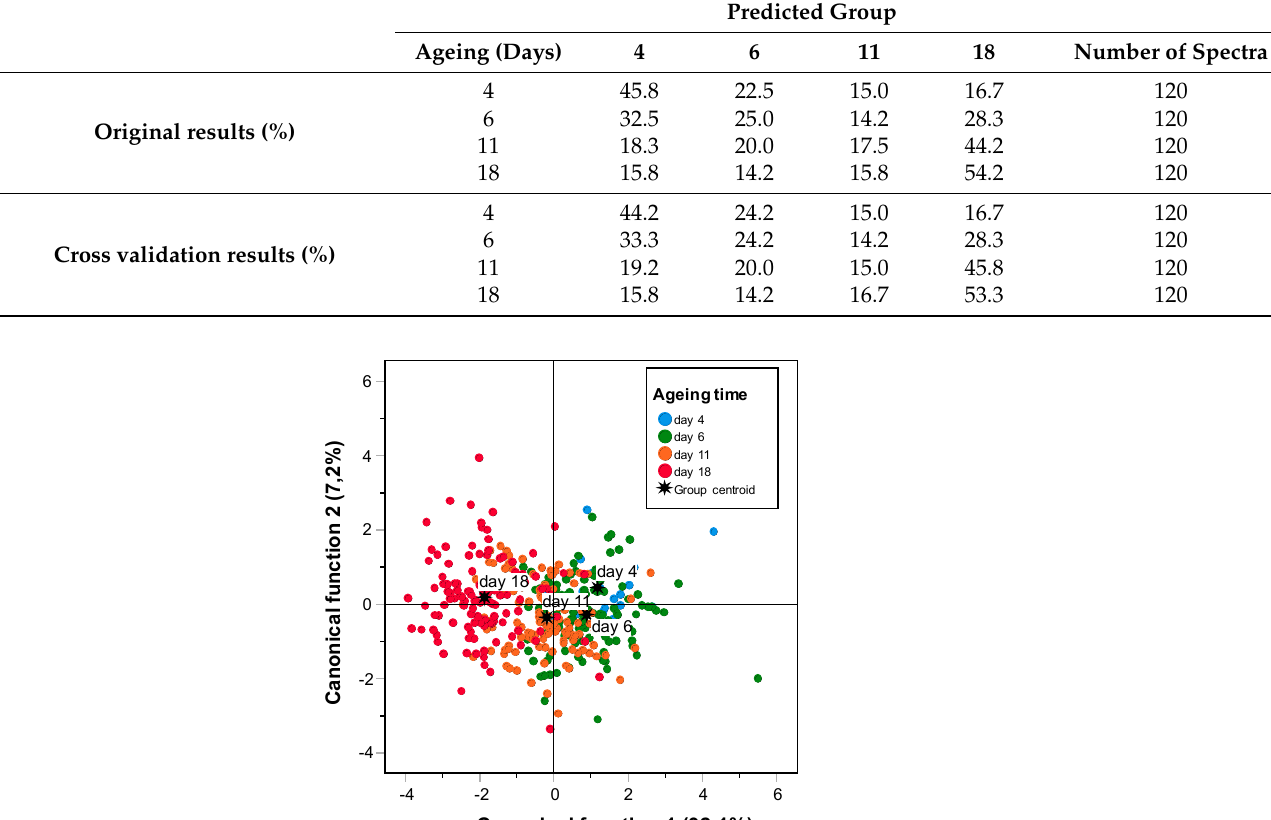
Table 3. Results obtained on the classification of the beef samples by the ageing (4, 6, 11, and 18 days) using the spectral information in the range between 1951 and 980 cm − 1 .